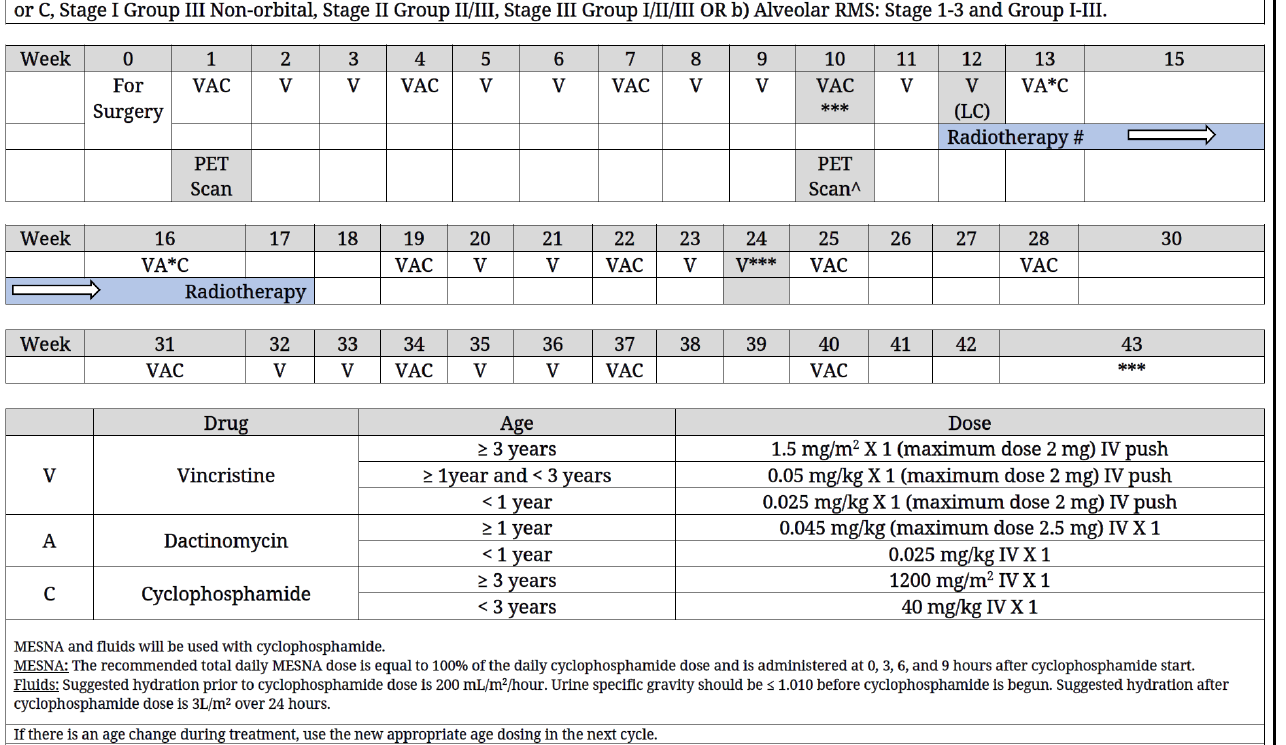
Figure 1: Roadmap for the treatment of intermediate-risk rhabdomyosarcoma The median EFS of RMS was not reached as well, the mean was 107 months (95%CI: 83-131.1) and the 5- year EFS rate was 77.8% (Figure 3). Four cases relapsed and the same cases died.